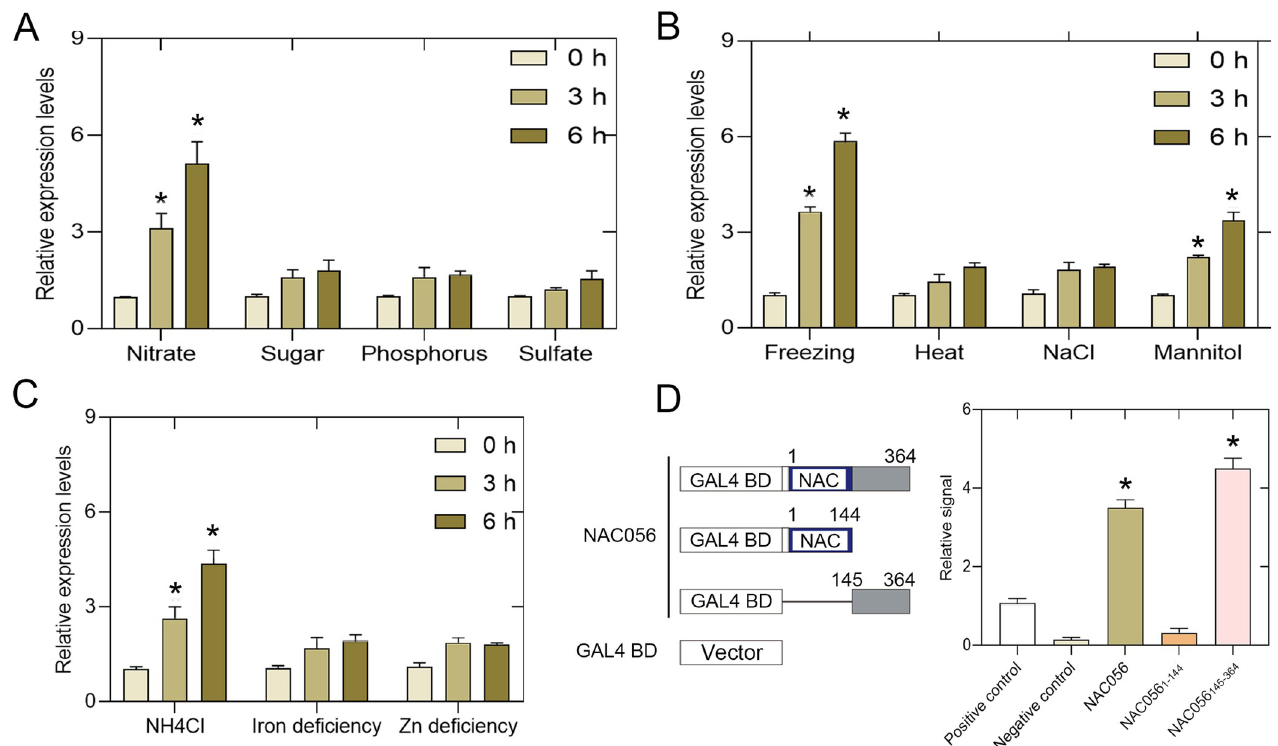
Fig 4. Analysis of NAC056 expression in response to environmental stress and transactivation activity analysis. A-C. Effects were determined in response to various abiotic stress treatments (100 mM NaCl, freezing ( − 4˚C), heat (28˚C), or 200 mM mannitol) or nutrition (6% sugar, 1 mM KNO 3 , 1 mM KH 2 PO 3 , 0.5 mM NH 4 Cl, 0.2 mM sulfate, 2 μ M FeSO 4 .7H 2 O, or 1 μ M ZnCl 2 ) on NAC056 expression levels in Arabidopsis roots. AtACT2 was used as an internal control. Values are given as mean ± SD, n = 3. � p < 0.05 by Student’s t -test. D. Transactivation activity assays of NAC056 in Arabidopsis protoplasts. The full-length open-reading frame (ORF) of NAC056 and its deletion constructs were used in the assay. NAC represents the DNA-binding domains of NAC056 . The negative control was the effector vector without the gene inserts. The effector vector used is shown in the left panel. The GAL4 transient expression assays were performed using Arabidopsis protoplasts, shown in the right panel. Three independent experiments were conducted. Values are given as mean ± standard error (SE), n = 3. � p < 0.05 by Student’s t -test.